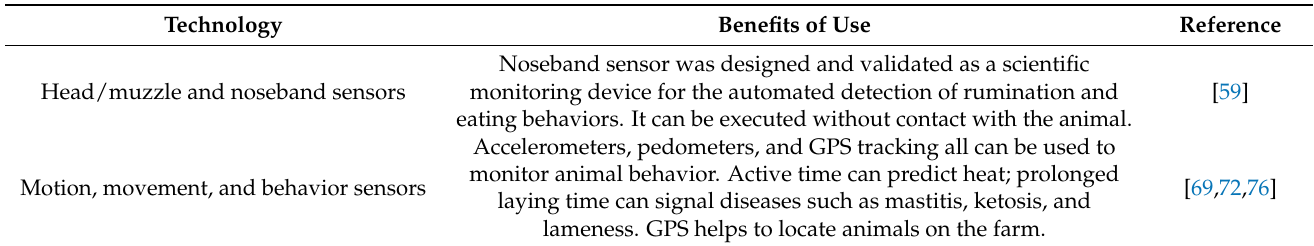
Table 3. Wearable sensors and their